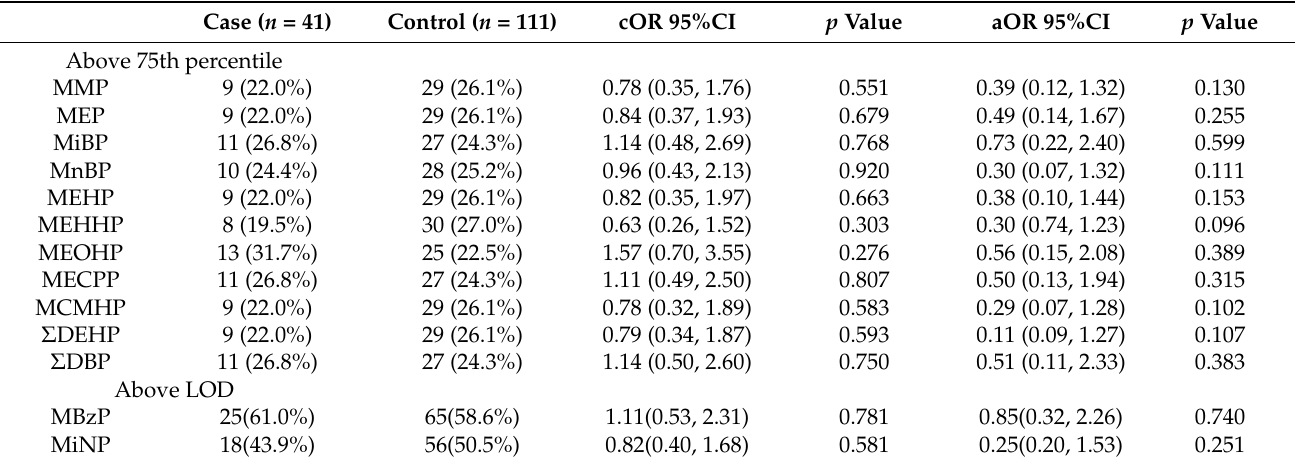
Table 4. Crude odds ratio (cOR) and adjusted odds ratio (aOR) for high urinary phthalate metabolite levels in the case and control groups.